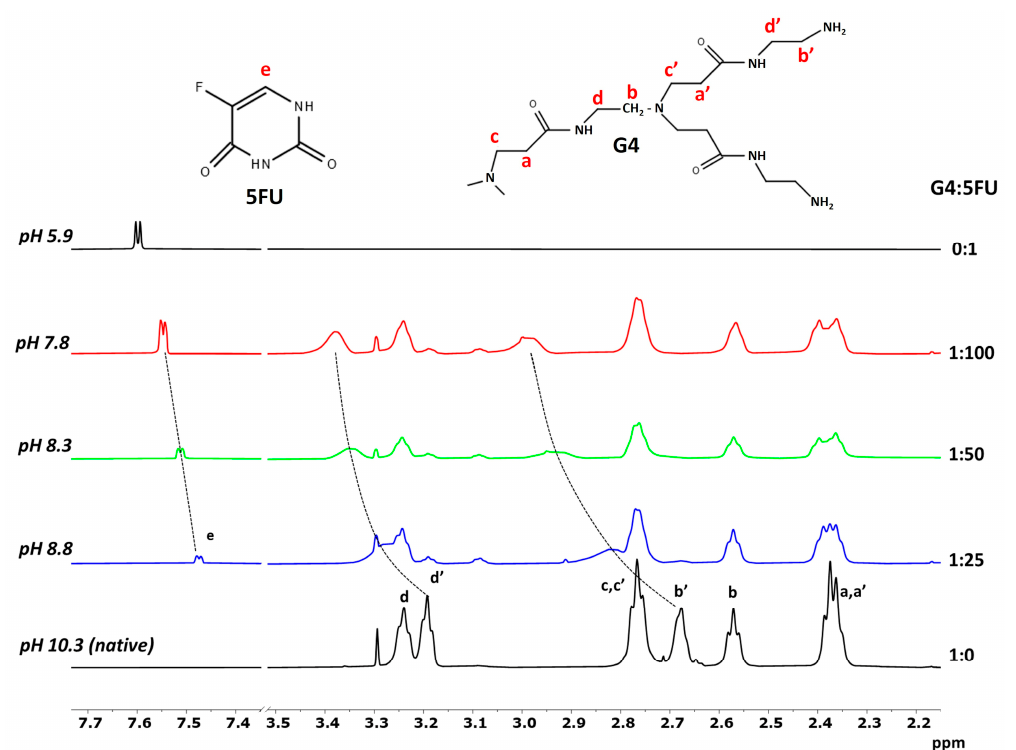
Figure 3. 1 H NMR spectra of G4PAMAM (bottom), 5FU (top), and dendrimer–drug mixtures at dif- ferent molar ratios and pH (G4PAMAM = 2 mg/mL; 50:50 vol% H 2 O/D 2 O; 30 °C). Labels: a–d denote the methylene protons in the core of dendrimer; a’–d’ denote the methylene proton in the outmost layer of the dendrimer; e denotes the hydrogen occupying position 6 in 5FU. The dotted lines serve to guide the eye only.